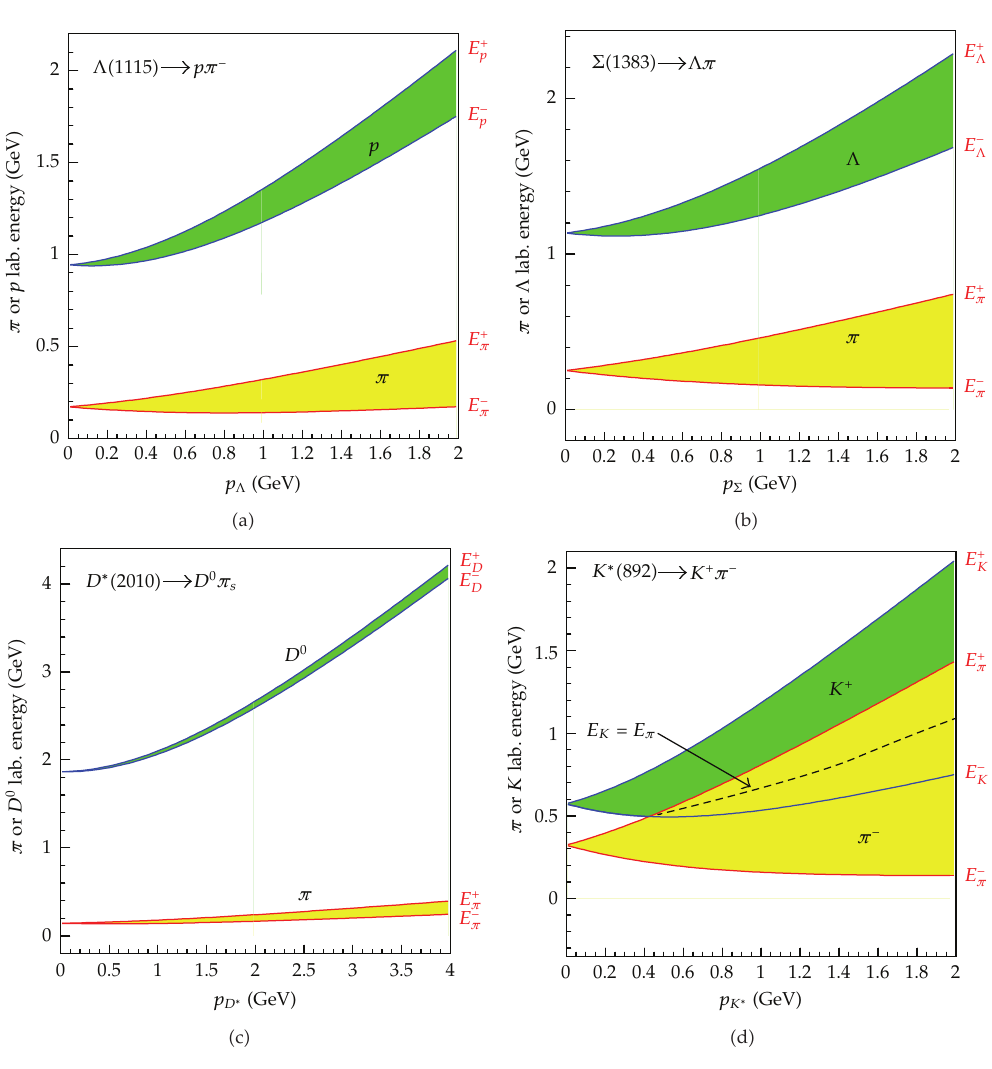
Figure 2: Phase space E -bands in R → a (cid:9) b decays as a function of the resonance momentum P R . The dashed line on (cid:3) d (cid:4) corresponds to (cid:3) 2.20 (cid:4)